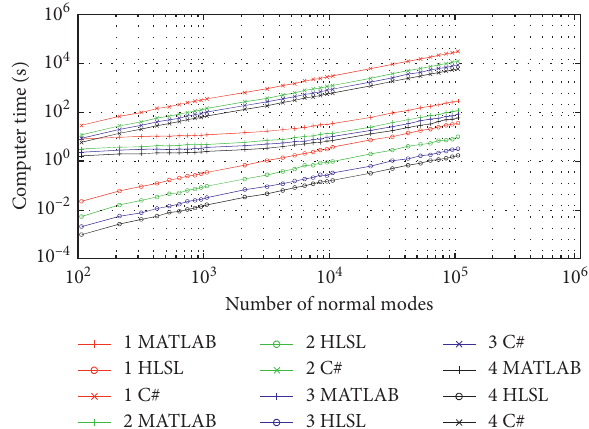
Figure 11: Computer times versus the number of normal modes.